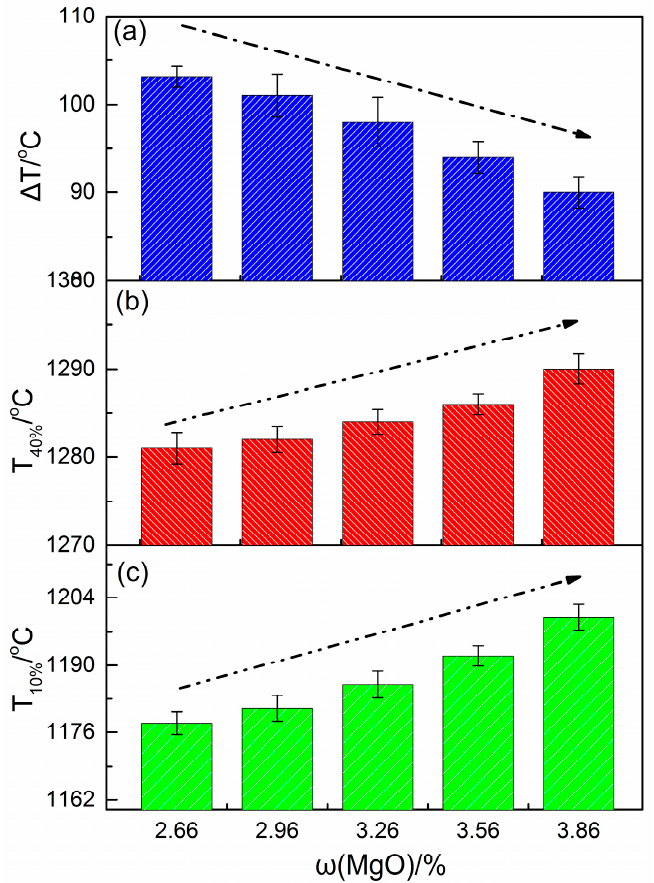
Figure 12. Softening–melting properties of the CCVTM sinter with various MgO concentrations: ( a ) T10%; ( b ) T40%; ( c ) softening interval.